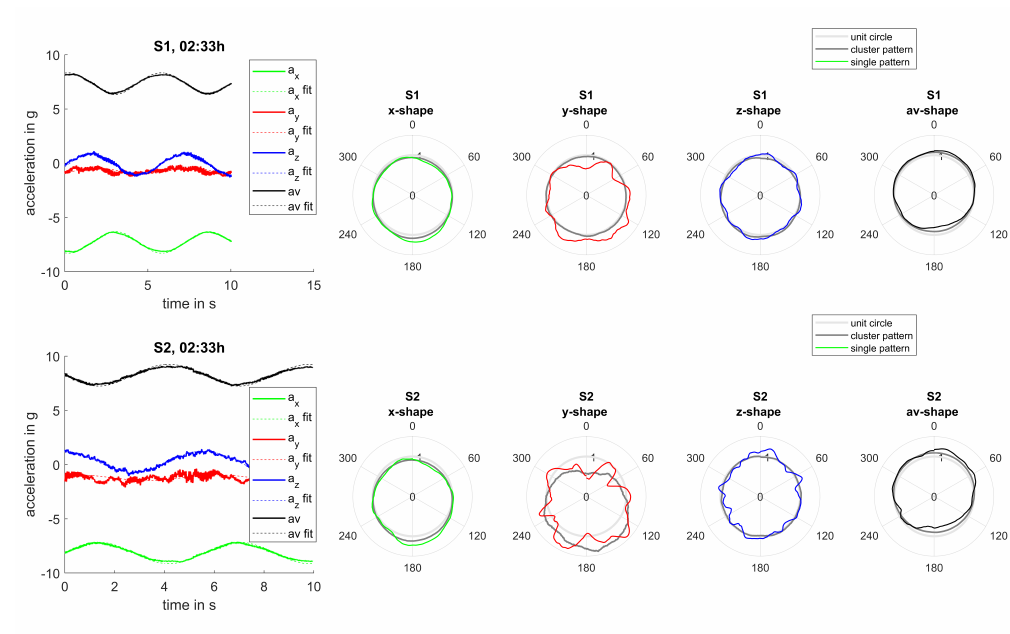
Figure 17. Joint analysis, event 2: Comparison of bending patterns for sensors S 1 and S